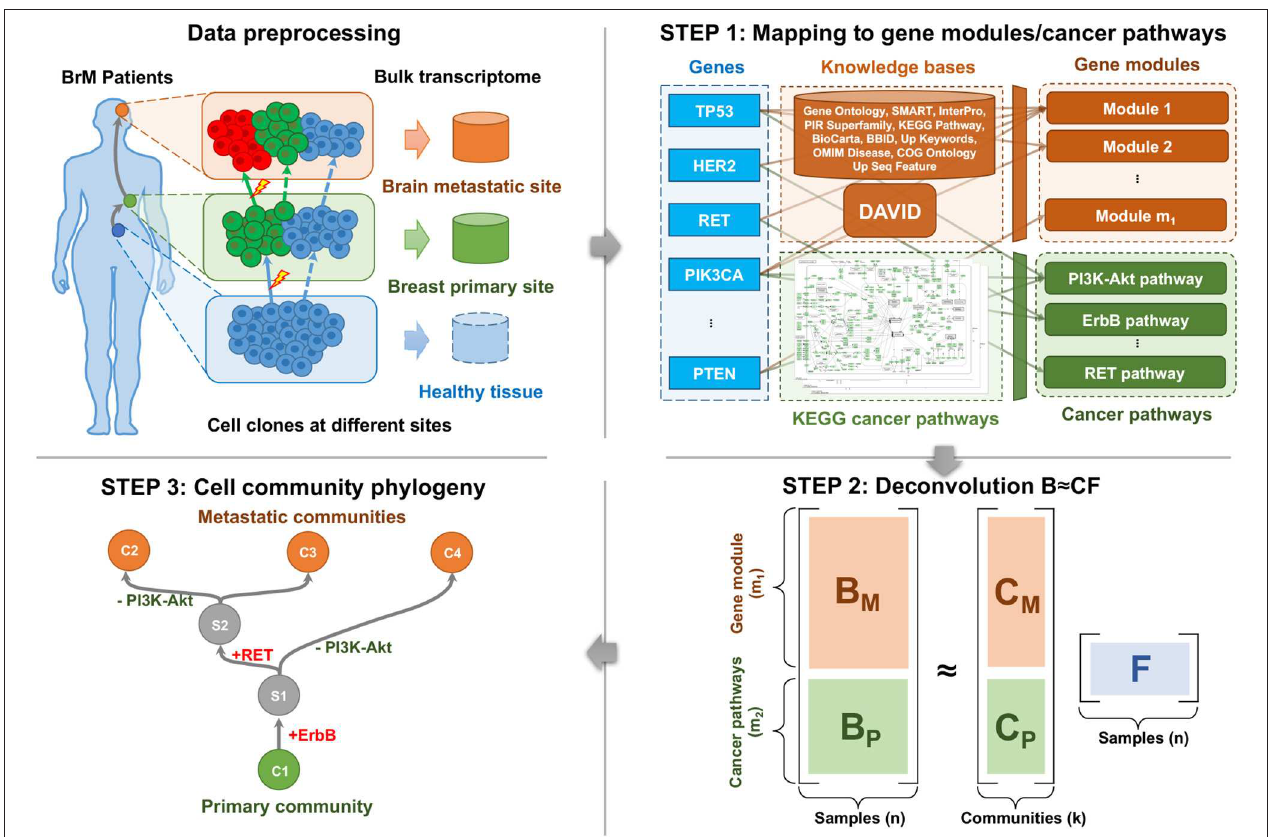
FIGURE 1 | The pipeline of BrM phylogenetics using matched bulk transcriptome.